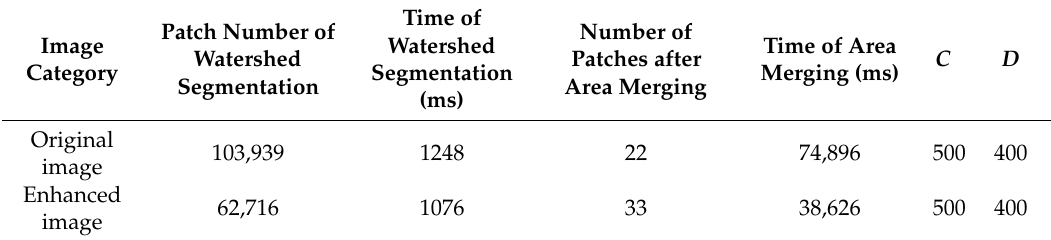
Figure 4. Comparison of segmentation results between pre- and post-contrast-enhanced images. Table 2. Statistical features derived from the Luv-RMWS algorithm.